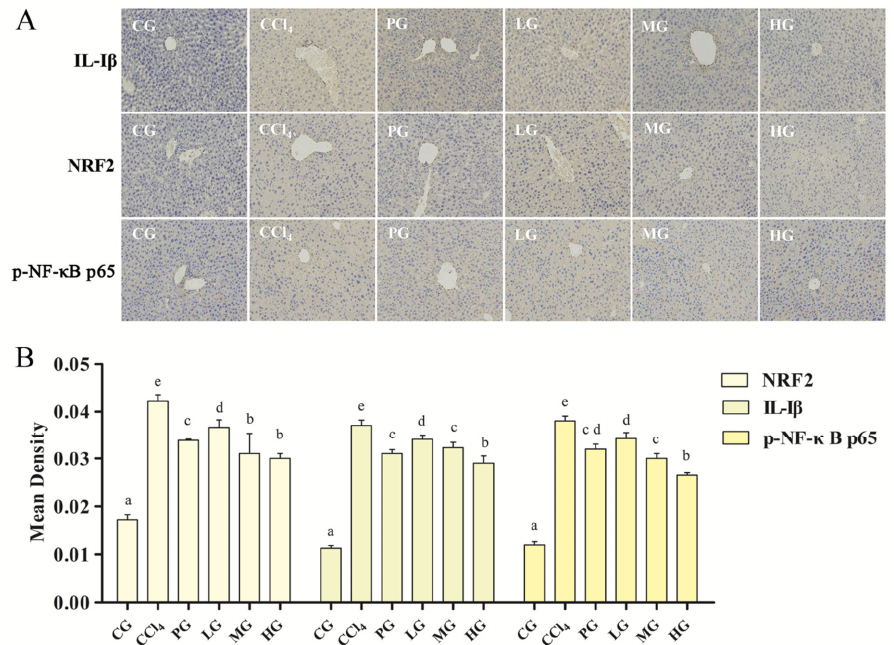
Figure 5. ( A ) Immunohistochemical results of hepatic IL-Iβ, NRF2, p-NF-κB p65 in acute liver injury mice (magnification 200×); ( B ) Quantitative analysis results, the same letter indicates no significant difference between groups ( p > 0.05); the different letters indicate significant difference between groups ( p < 0.05).